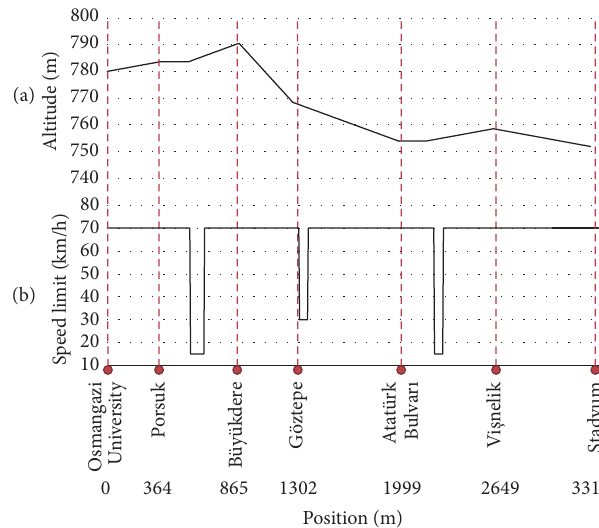
Figure 5: Altitude (a) and speed limitation (b).